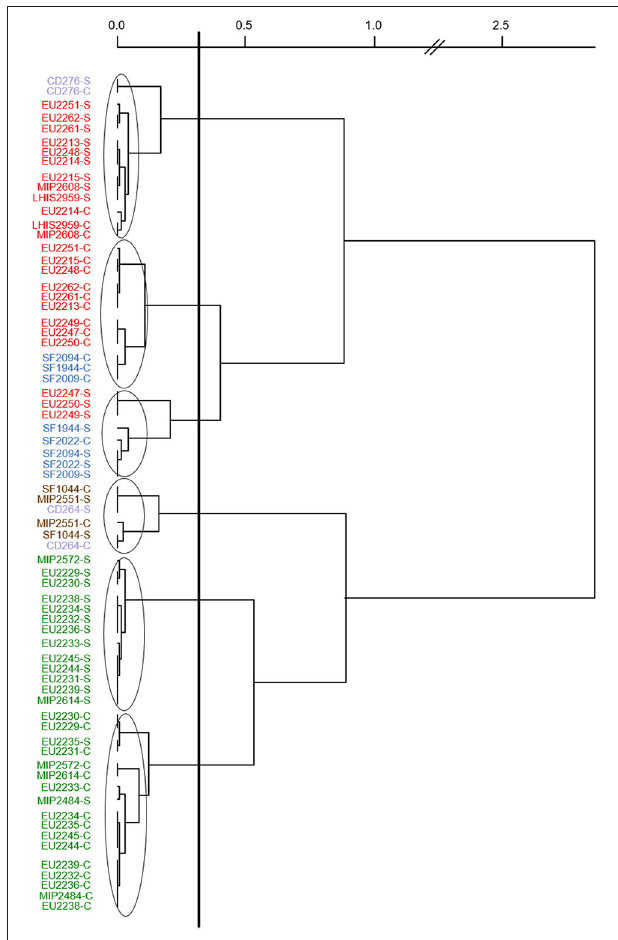
FIGURE 2 | Ward’s hierarchical classification realized with squared Euclidian distance on PCA components of the 35 protective cultures inhibition scores against the 7 targets in both salmon and cod juices. Strain code followed by a letter S: Salmon juice, a letter C: cod juice. Strains in red: L . gelidum , in blue: C . maltaromaticum , in green: L . piscium , in brown: C . inhibens MIP2551 and A. viridans SF1044, in violet: V . fluvialis CD264 and V. penaei